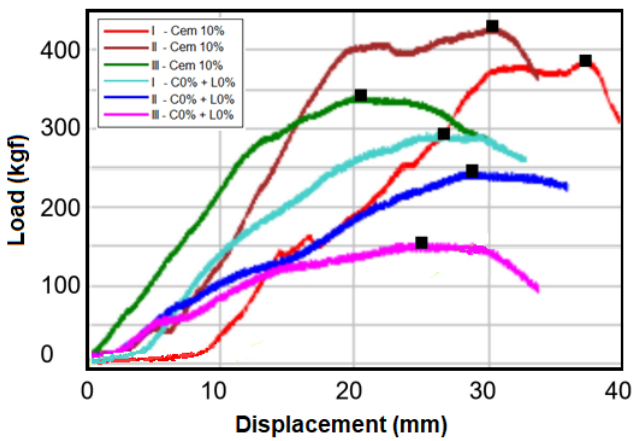
Figure 9. Load × Displacement curve for Cem-10% and C-0% + L-0% compositions.